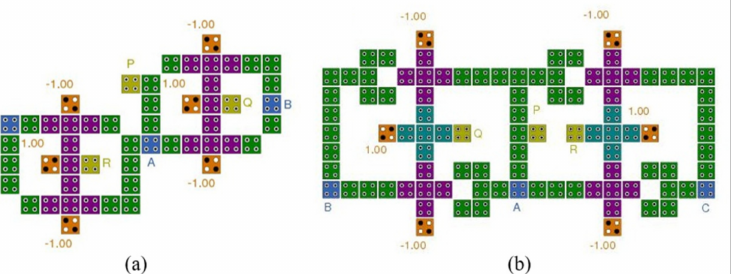
Figure 4. The layout of the double Feynman gates (proposed by Bahar, Waheed [16]): ( a ) the first design for double Feynman gates, and ( b ) the second design for double Feynman gates.